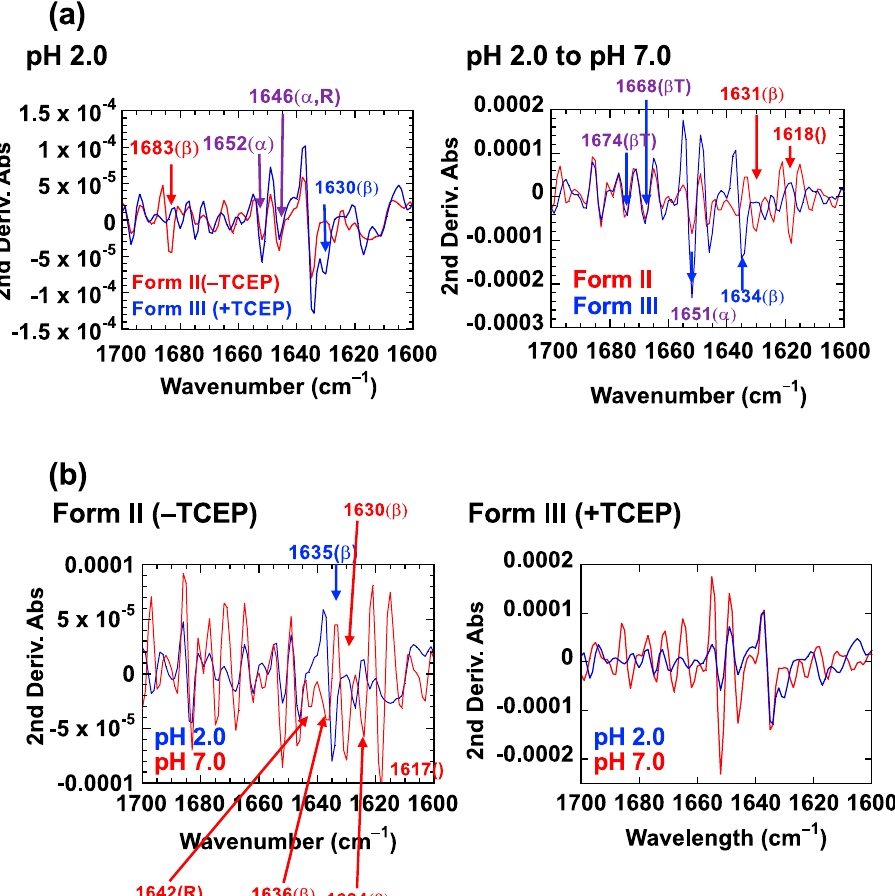
Figure 6. Secondary derivative analysis of ATR FT-IR spectra obtained from samples of Form II and Form III HdeB fibrils measured in D 2 O. HdeB fibrils were formed in the absence (Form II) and presence (Form III) of TCEP at pH 2, and aliquots were taken from each of these samples and mixed with Tris base to adjust the pH of the aliquots to 7. These four samples were then lyophilized for 48 h to remove the water contained. Each sample was applied to the FT-IR spectrometer and 4 µL of deuterium oxide was directly applied to rehydrate the sample. The IR spectra of the samples were then measured. In ( a ), Form II and Form III samples are compared both before (pH 2) and after (pH 2 to pH 7) shifting the pH to 7. In ( b ), changes in FT-IR spectra induced by pH shift are probed for Form II and Form III samples, respectively. The graphs correspond to second derivative spectra of the IR absorbance spectra in the 1700 cm − 1 to 1600 cm − 1 Amide I region. Distinctive minima (denoting the wavenumber positions of prominent IR absorbance peaks) are highlighted according to the sample attributed. In ( a ), red traces and notations of wavenumber correspond to Form II HdeB samples, blue traces and notations of wavenumber correspond to Form III fibril samples. Magenta wavenumber notes indicate minima observed similarly in both samples. In Panel ( b ), blue traces and notations of wavenumber correspond to samples maintained at pH 2 up until the lyophilization step, and red traces and wavenumber notes correspond to samples where the pH was adjusted to 7 using Tris base prior to